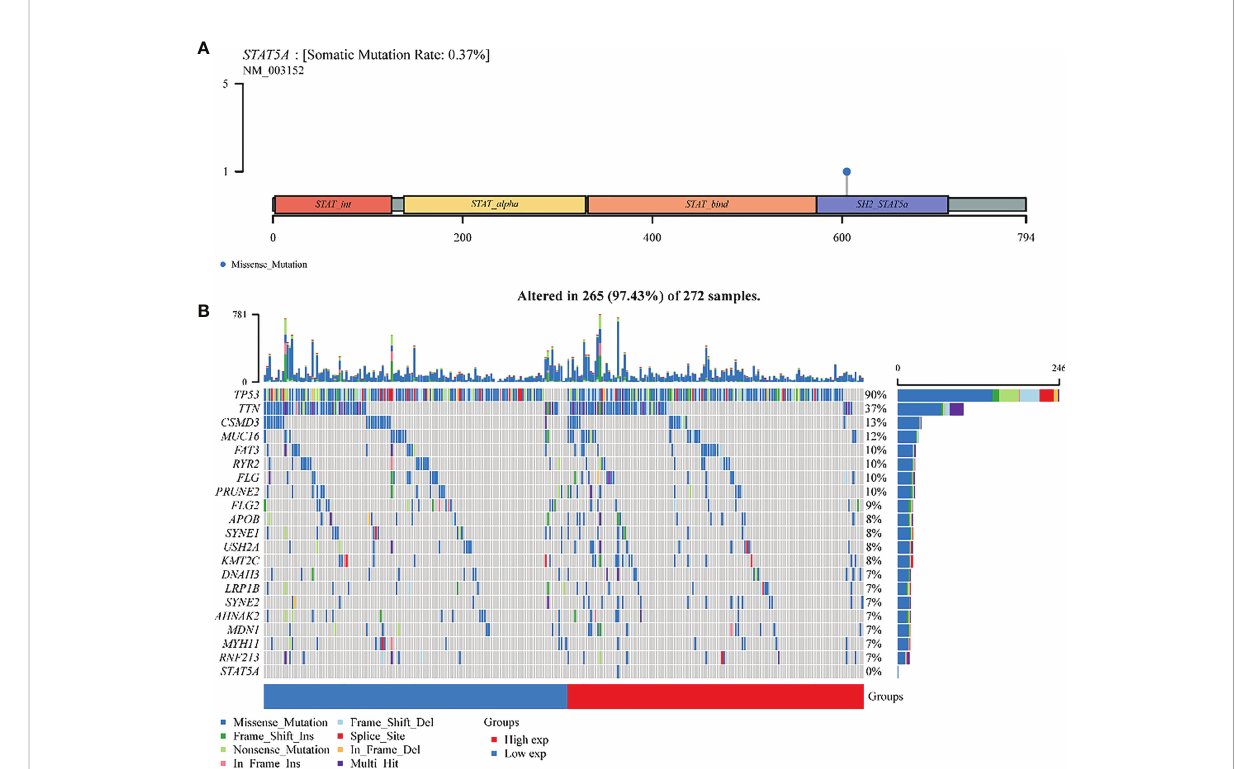
FIGURE 7 A landscape analysis of STAT5A gene mutations in ovarian cancer. (A) Lollipop charts of the mutated STAT5A gene. (B) Oncoplot displays the somatic landscape of OV TCGA cohorts. The genes and samples are sorted according to their mutation frequency and histology; Above the legend, the bar plot shows the number of mutations